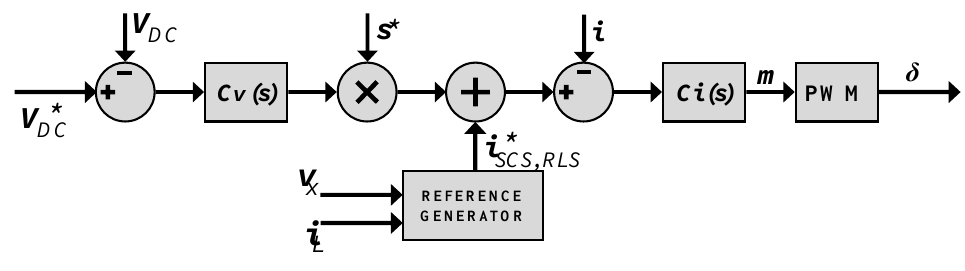
Figure 3. Block diagram of control scheme applied to shunt active power filter with sinusoidal current synthesis (SCS) or resistive load synthesis